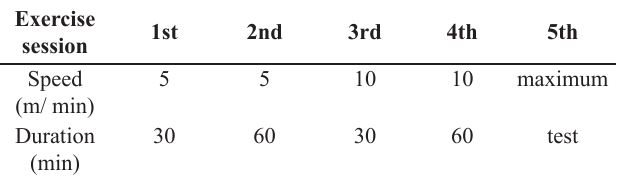
Table 1. Adaptation scheme to treadmill